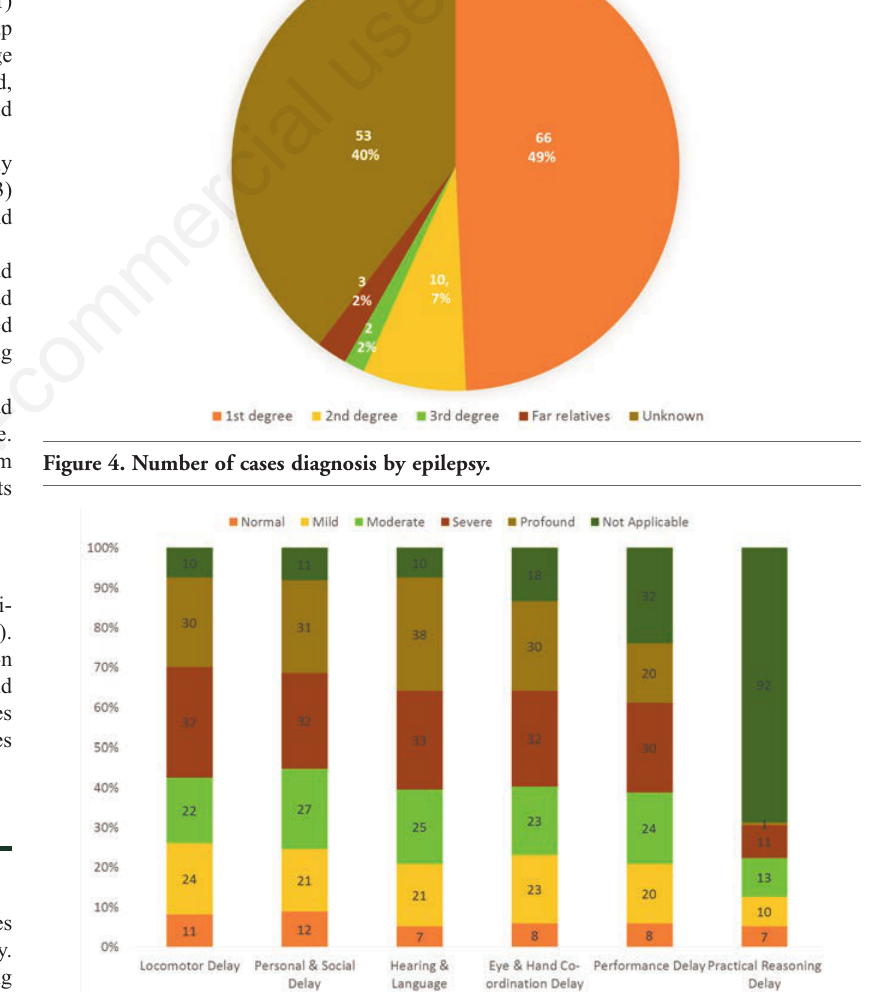
Figure 5. Overall development trajectory in development delay